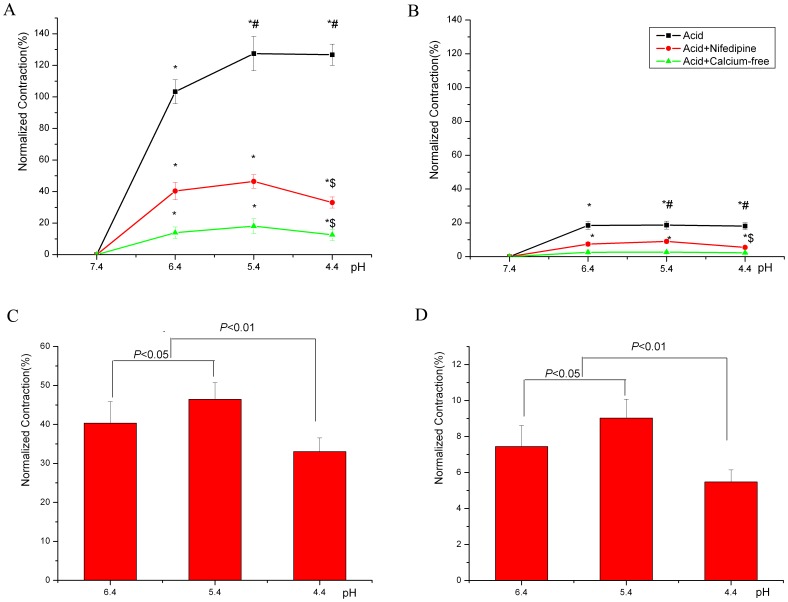
The role of extracellular calcium influx in severe acidosis-induced contraction of thoracic aortas from SHRs and Wistar rats.A, SHRs; B, Wistar rats: Effect of voltage-dependent calcium channel (VDCC) inhibitor nifedipine (10µM) on severe acidosis-induced contraction of thoracic aortas from SHRs (n = 6) and Wistar rats (n = 6) at different pHs and extracellular calcium-free solution. C, SHRs; D, Wistar rats: Effect of nifedipine on remnant contraction of thoracic aortas. *P<0.01, compared with the contraction at pH 7.4. #
P<0.05, compared with the contraction at pH 6.4. $
P<0.01, compared with the the contraction at pH 5.4.